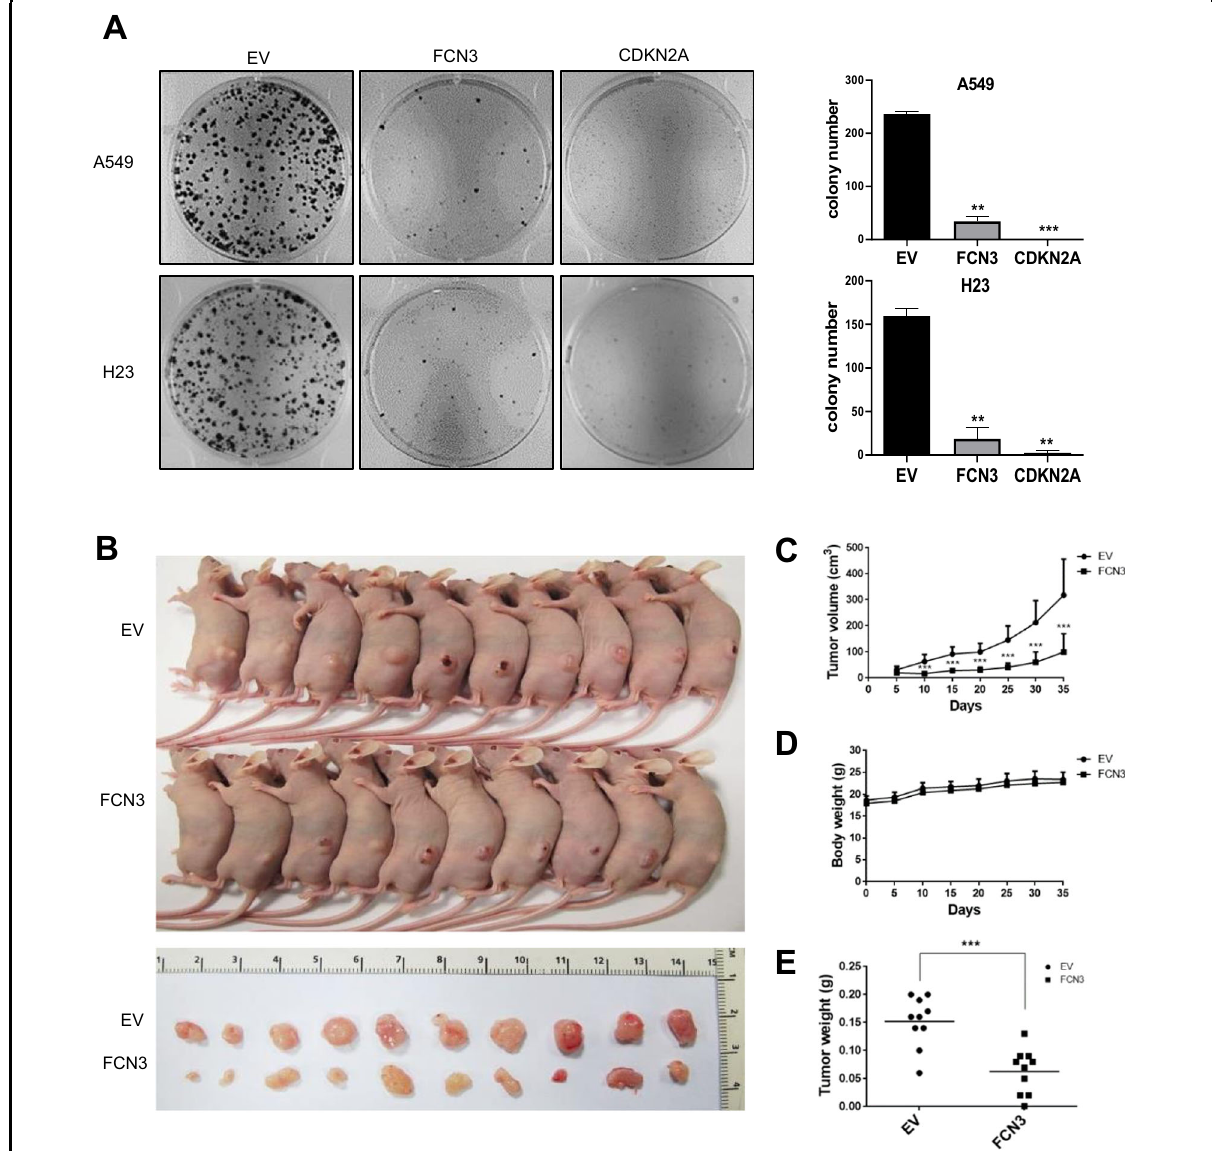
Fig. 2 Cell growth is inhibited by FCN3 . A A549 and H23 cells were transduced with control empty virus (EV), FCN3-expressing virus, or CDKN2A- expressing virus and allowed to grow for 8 and 12 days, respectively. Resulting colonies were stained with Coomassie blue, and the number was determined. Graphs to the right show result from three independent experiments as mean ± SEM. Note the strong decrease in the number of colonies in FCN3 -expressing cells. B Photographs of mice with xenograft tumors (top) and of excised tumors (bottom). The mice were sacri fi ced 35 days after cell injection. Note that tumors from the FCN3-expressing A549-injected group show decreased tumor development compared to mice in the control group injected with control EV-transduced A549 cells. C Growth curves of xenograft tumor. Tumor volume was measured every 5 days. N = 10 for both groups. D Body weight of BALB/c nude mice was measured every 5 days. E The weight of all tumors isolated from EV group and FCN3 group. The lines in the middle represent the median levels. (**) and (***) represent P -values of <0.01 and <0.001 from t tests,